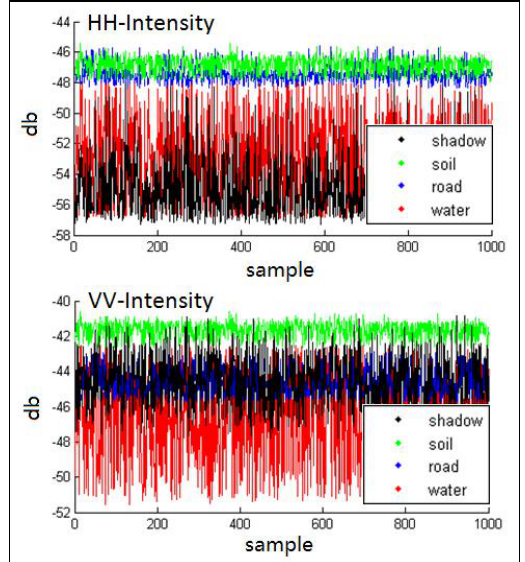
Figure 4. The bare soil, the road, the water body and the building shadow in HH and VV channels of the XSAR